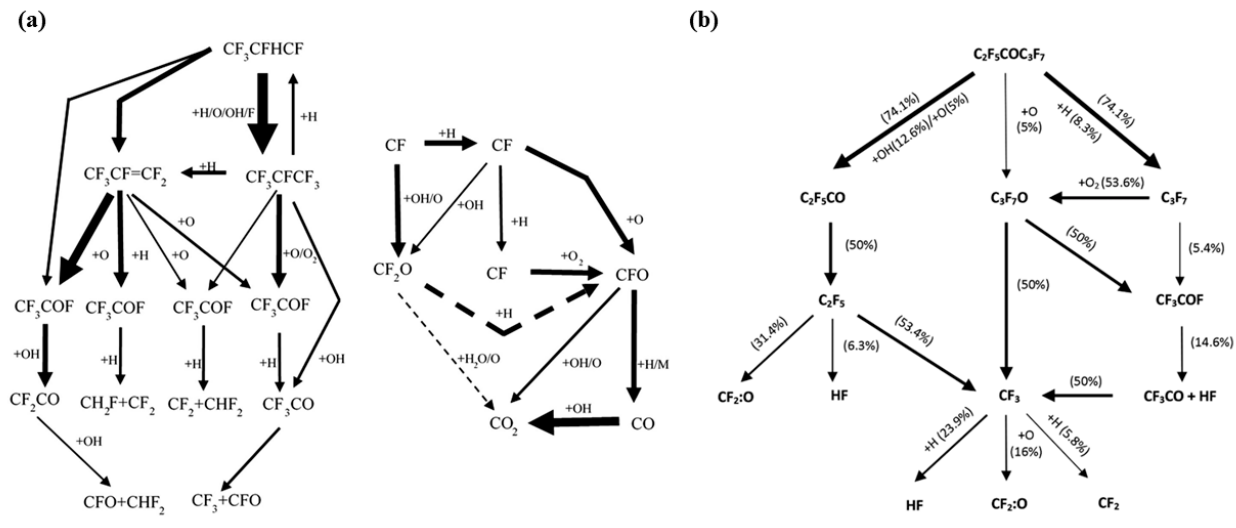
Figure 11. Fire extinguishing mechanism of ( a ) HFC-227ea [115] and ( b ) Novec-1230 [122]. 2-BTP (2-bromo-3,3,3-trifluoropropene), as a new clean gas fire extinguishing agent